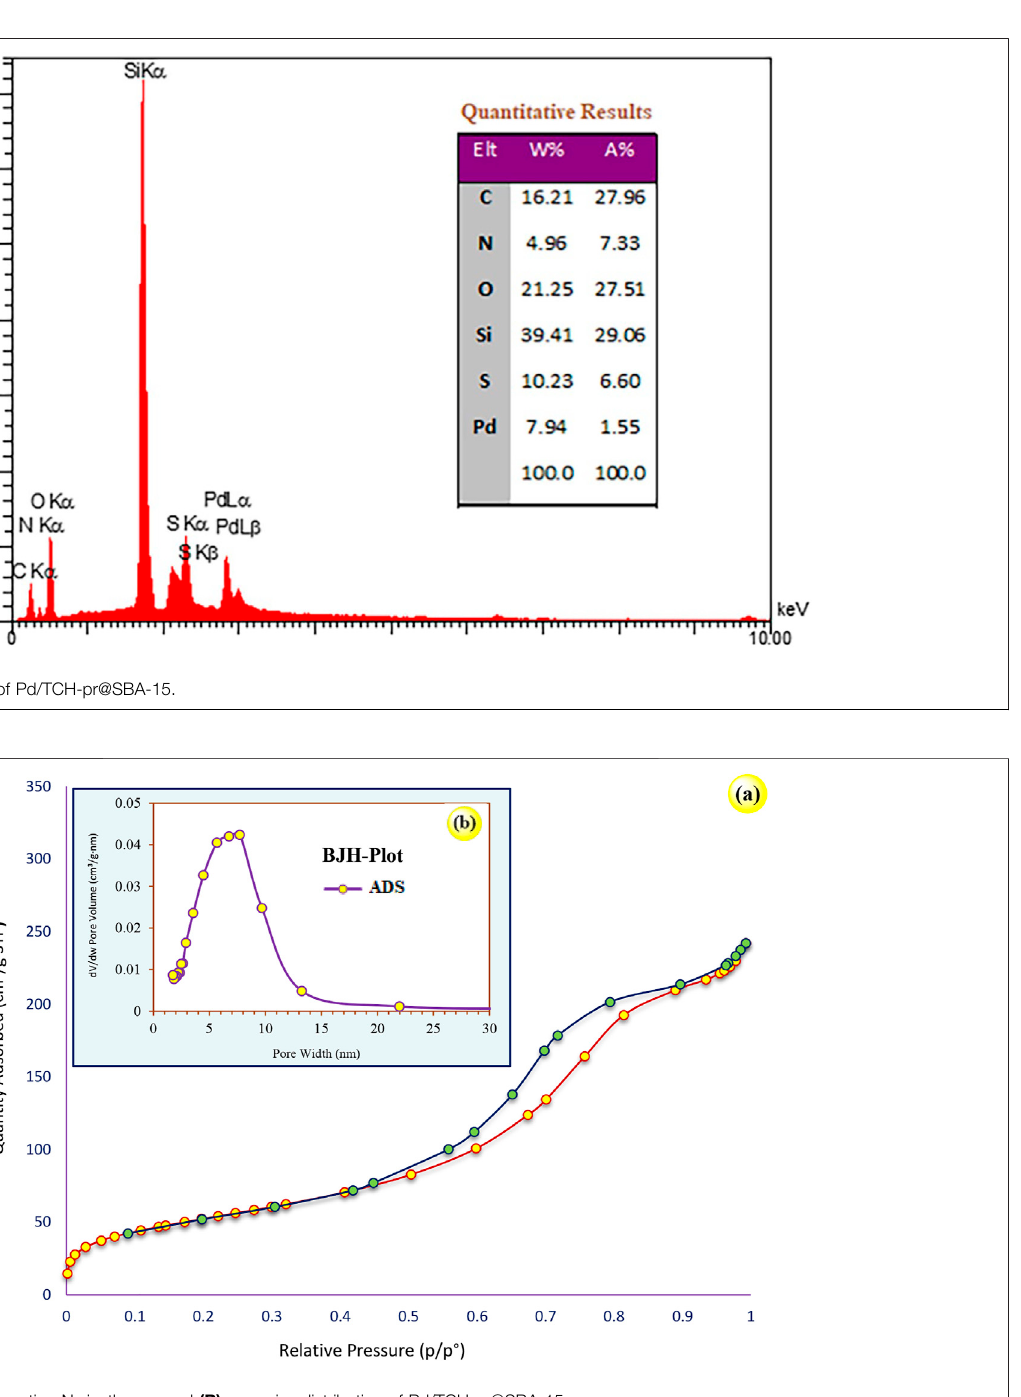
Frontiers in Chemistry |